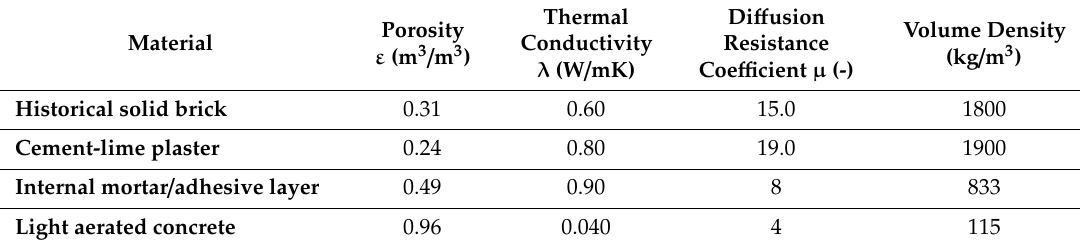
Table 4. Data used in hygrothermal